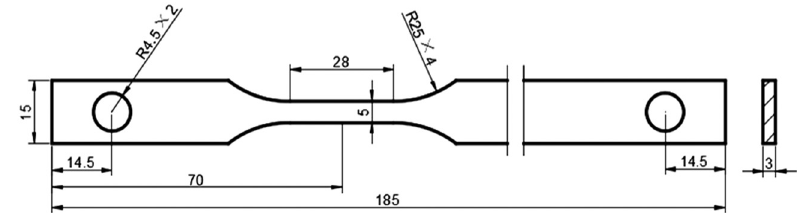
Figure 1: Dimensions of samples for SSRT